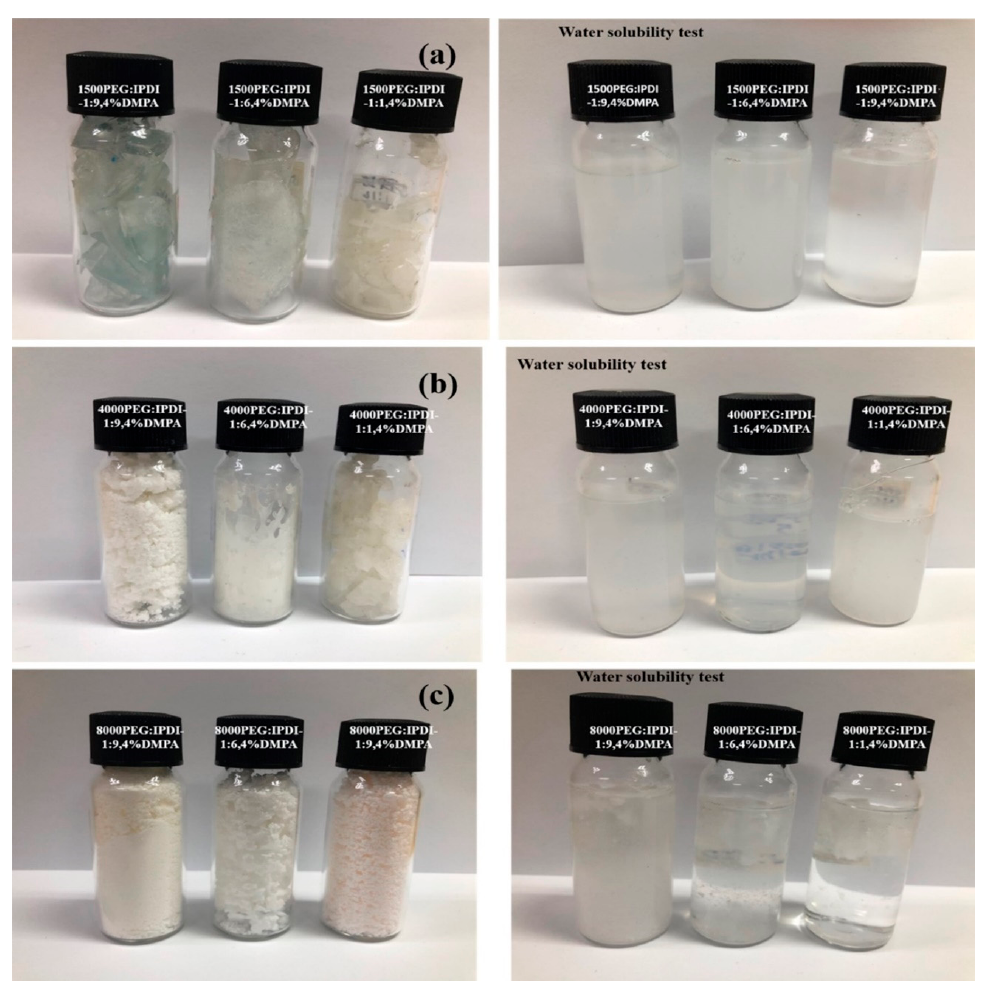
Figure 6. Water solubility test results: ( a ) 1500PEG:IPDI 1:9, 4% DMPA, ( b ) 4000PEG:IPDI 1:9, 4% DMPA, ( c ) 8000PEG:IPDI 1:9, 4% DMPA.